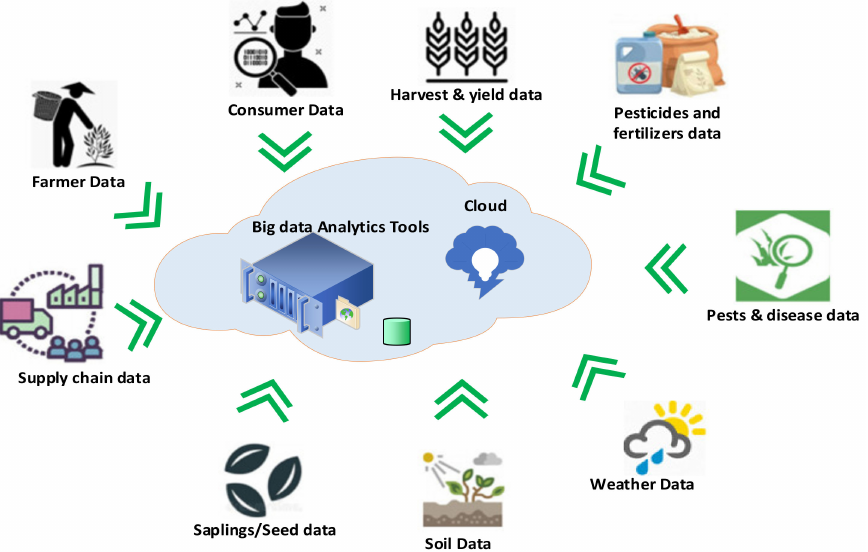
Figure 3. Information management and decision-making